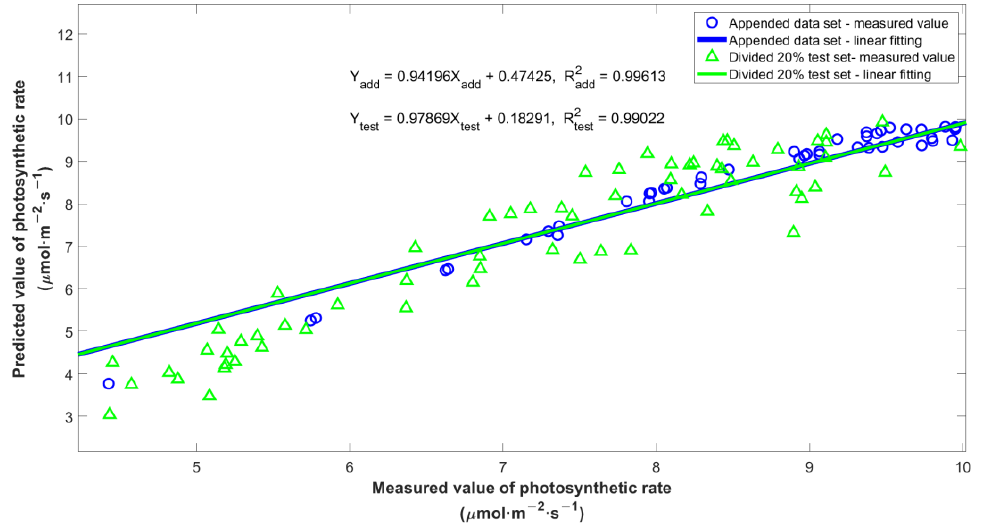
Figure 6. Correlation of measured and simulated values in appended dataset (blue) and divided 20% test set